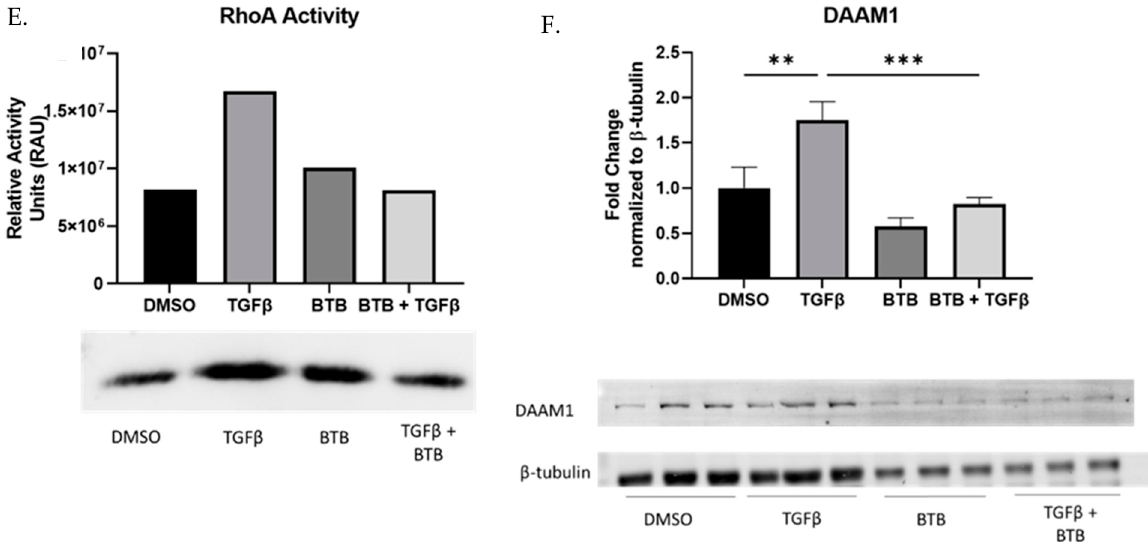
Figure 7. BTB inhibits RhoA mediated signaling. Fibroblasts were treated with 1 ng/mL TGF β and/or 50 µM BTB for 48 h before protein was harvested. The expression of ROCK1, p-cofilin, mDia, and profilin was examined ( A – D ). A RhoA activity assay was performed 20 min after stimulation ( E ) and DAAM1 expression was examined ( F ). Data were analyzed by ANOVA. n = 3 technical replicates/group. * p < 0.05, ** p < 0.01, *** p < 0.001, **** p < 0.0001. ROCK1 and mDia are both regulated by the GTPase RhoA [47]. Given the ability of